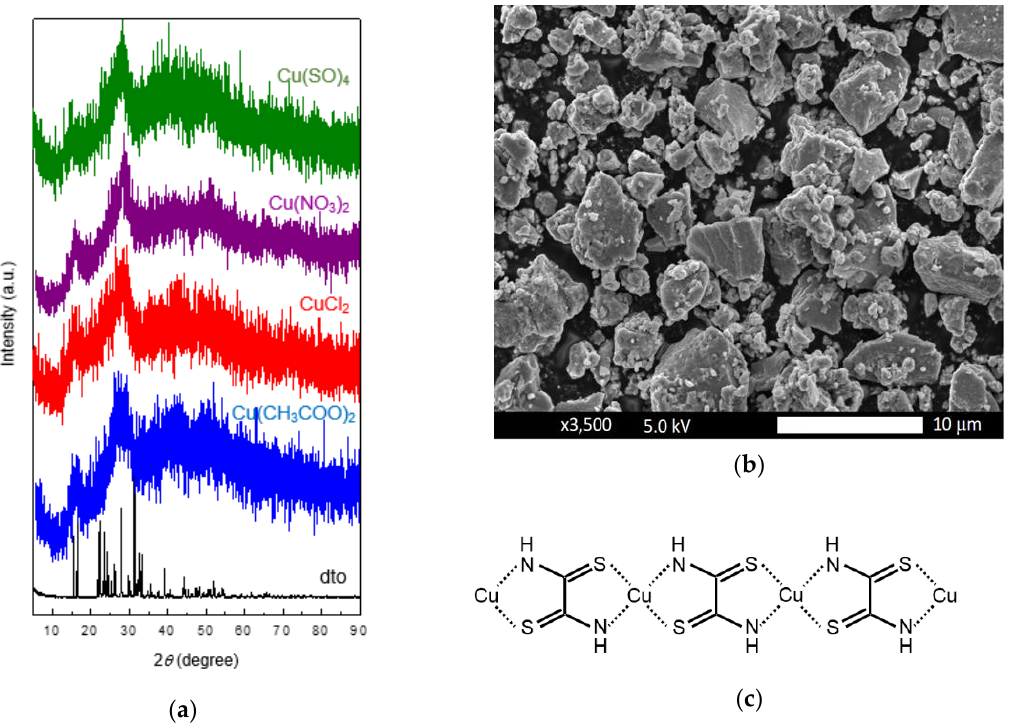
Figure 1. ( a ) XRD patterns of dto, and Cu(dto) compounds obtained from different copper salts. ( b ) SEM image of Cu(dto) compound obtained from CuSO 4 ( c ) proposed polymeric chain structure of Cu(dto) chelate polymer [16].